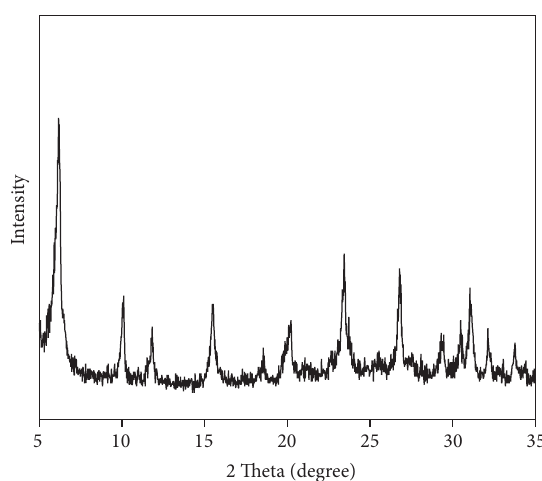
Figure 1: XRD patterns of the composite